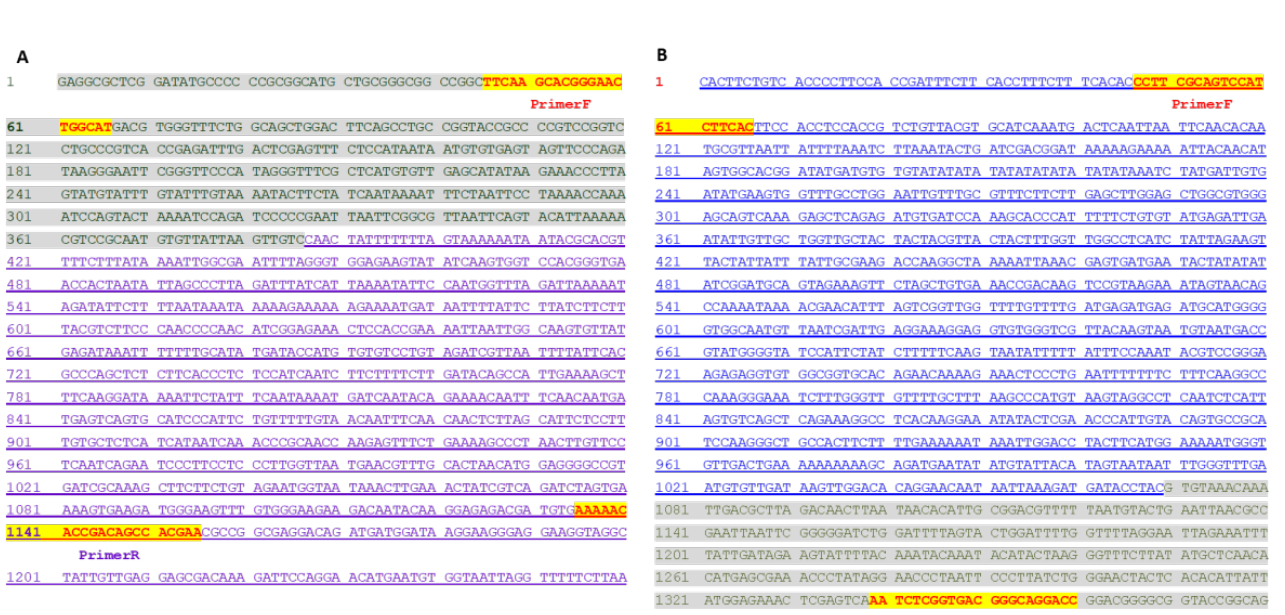
Figure A1. The identification of Basta resistance in transgenic plants. ( A ) Basta painting of T 0 gener- ation transgenic plant in the greenhouse using a 1:1000 diluted solution of the herbicide Basta (135 g L − 1 ). ( B ) LibertyLink strip analysis of T 0 generation transgenic plants; lanes 1 – 8 are transgenic plants.